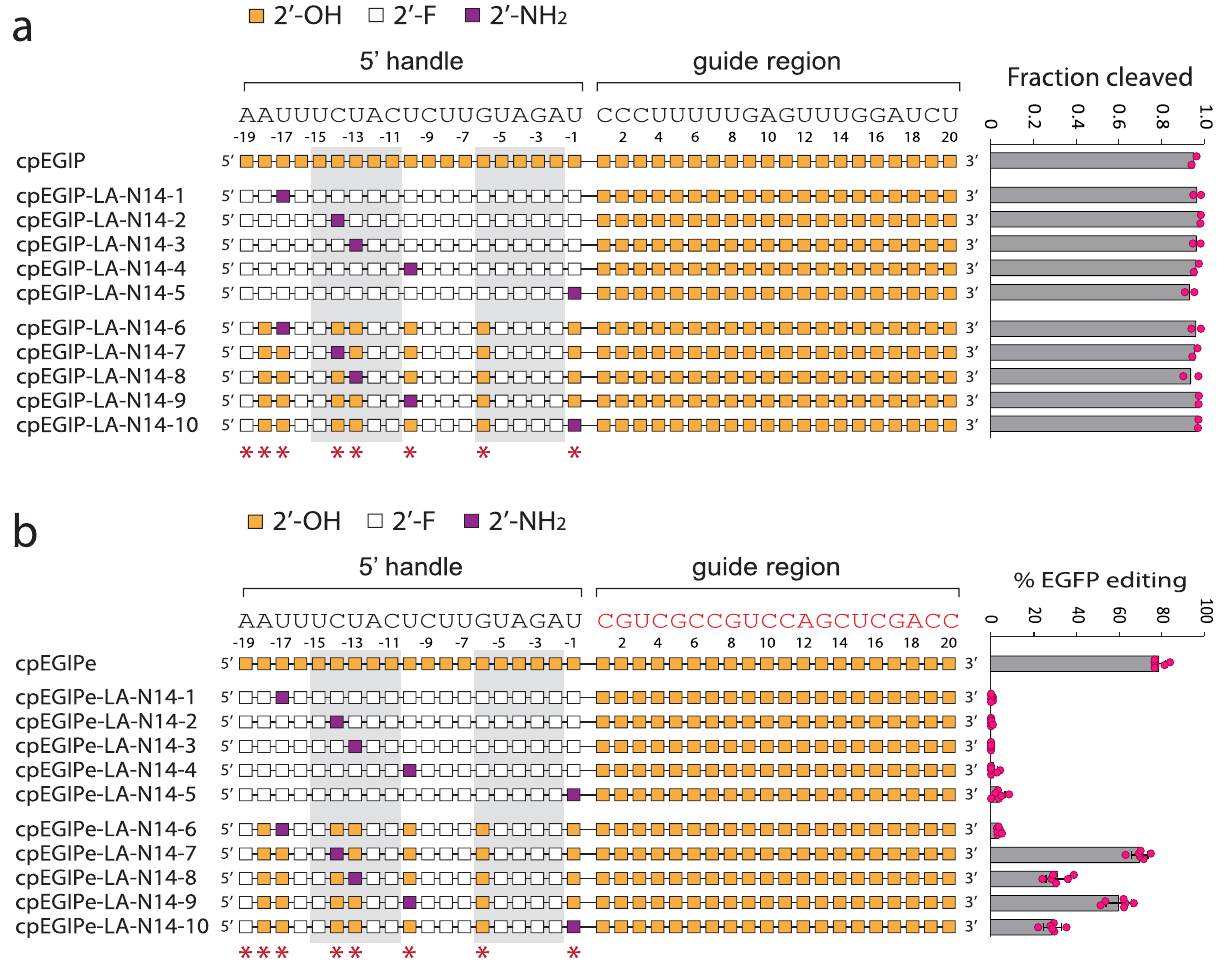
Fig. 4 In vitro cleavage and cell-based editing activity of As Cas12a using crRNA guides modi fi ed with 2 ′ -F and 2 ′ -NH 2 combinations. Chemical modi fi cation patterns are illustrated with corresponding mean in vitro cleavage activity ( n = 2) ( a ) or mean cell-based editing activity ( n = 6) ( b ) shown to the right. Error bars are standard deviation and replicates are biological. For both panels, nucleotides of the 5 ′ handle that are predicted from structural data to make polar contacts through 2 ′ -OH hydrogen bonding are indicated with red asterisks below. The base-paired stem nucleotides of the 5 ′ handle pseudoknot are enclosed with light gray boxes. In vitro cleavage and cell-based editing assays utilize the distinct guide sequences that are shown above each schematic. Source data are provided as a Source Data fi